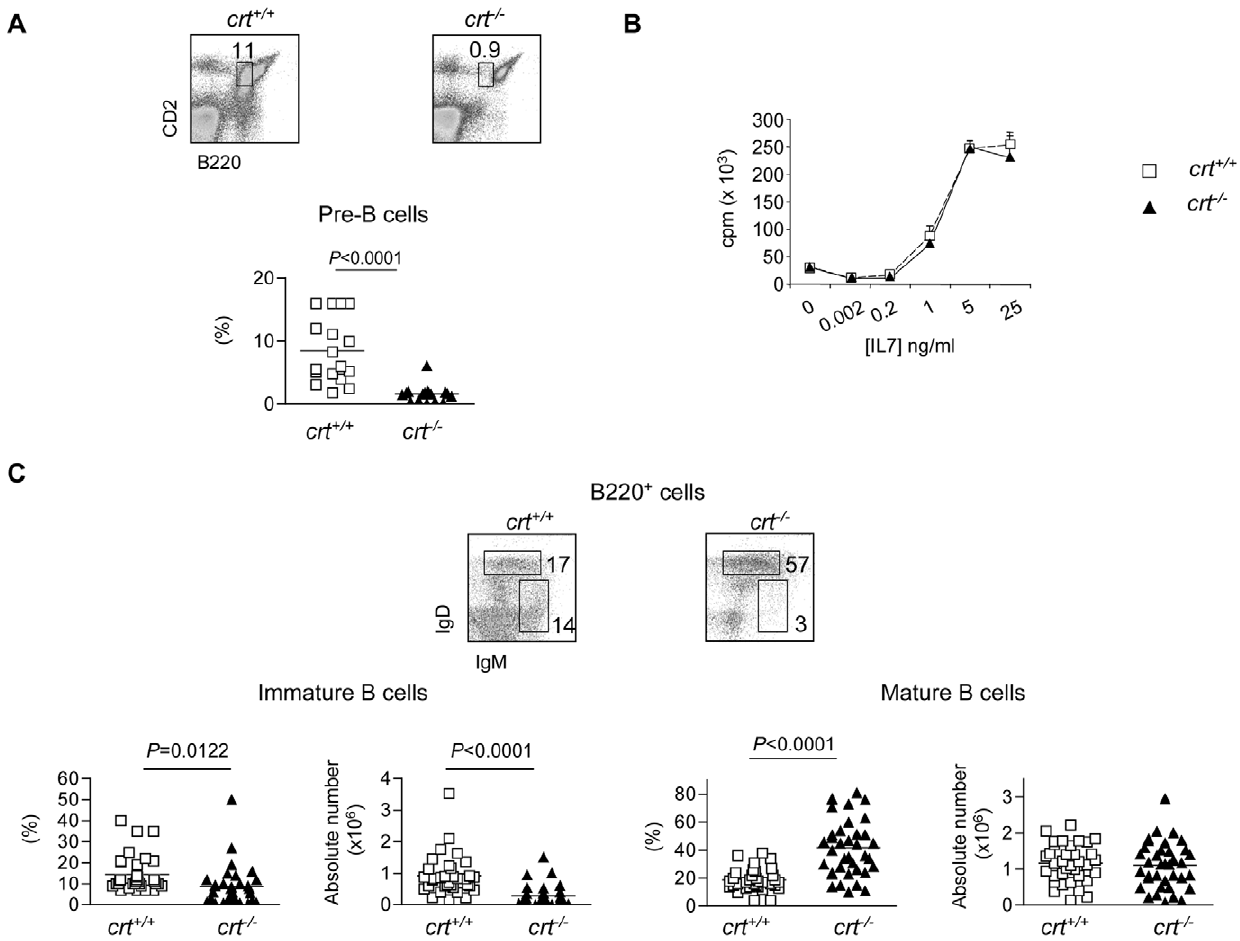
Figure 2. B cell progenitors but not mature B cells depletion in the BM of crt 2 / 2 FLC. (A) Dot plot analysis of BM cells from FLC stained with B220 and CD2 antibodies. The gate corresponding to pre-B cells used for the statistical analysis (below) is indicated. (B) 3 H-thymidine incorporation to serial dilutions of recombinant IL-7 by sorted BM pro- and pre-B cells (see Results). (C) Dot plot analysis of electronically gated B220 + cells stained with IgM and IgD antibodies with statistical analysis of the respective subsets (below). Mice were analysed at weeks 12–18 after reconstitution.